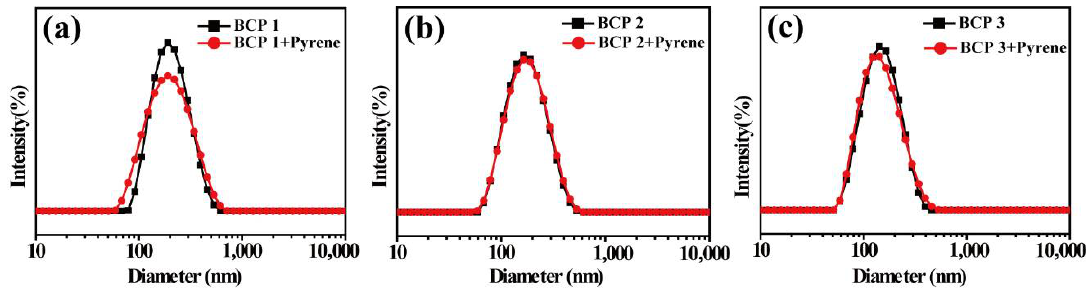
Figure 6. DLS curves of ( a ) BCP1, ( b ) BCP2 and ( c ) BCP3 micelles before and after encapsulating pyrene.